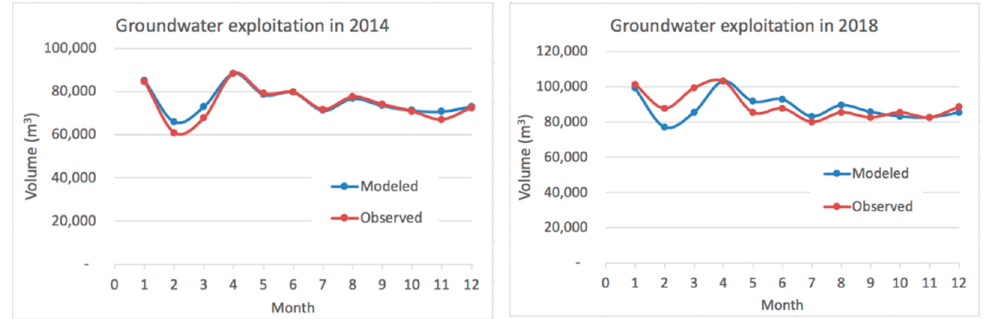
Figure 6. Calibration and validation results of the WEAP model for Con Dao Island.